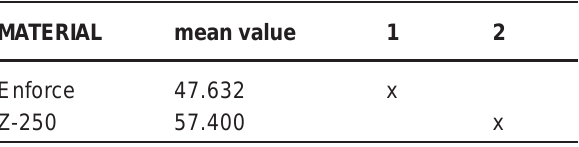
x significant statistical difference